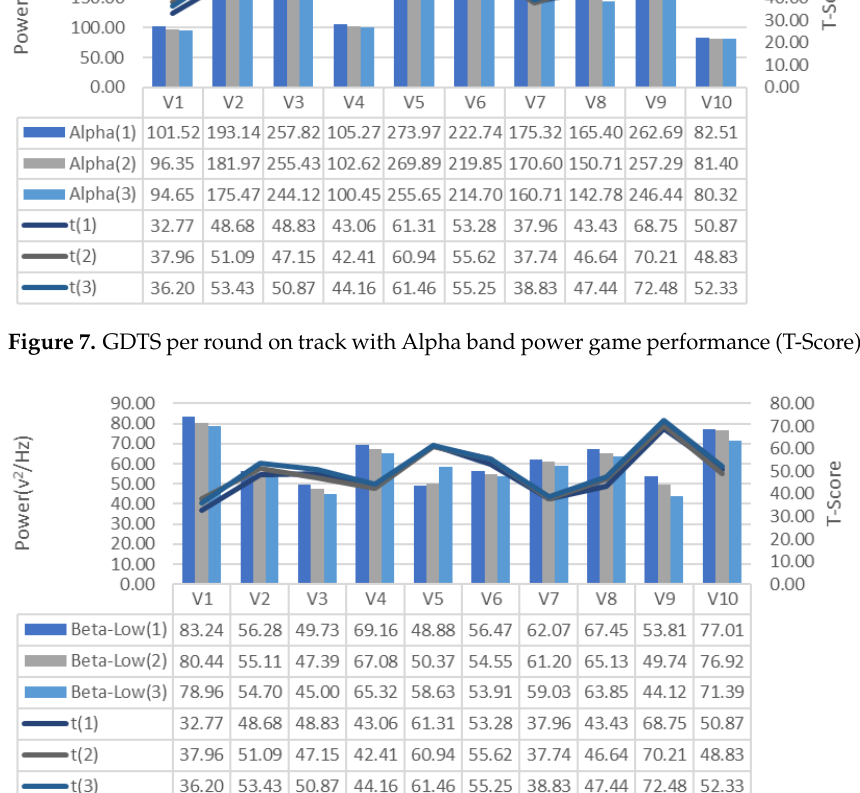
Figure 8. GDTS per round on track with Beta-Low band power game performance (T-Score) relationship.